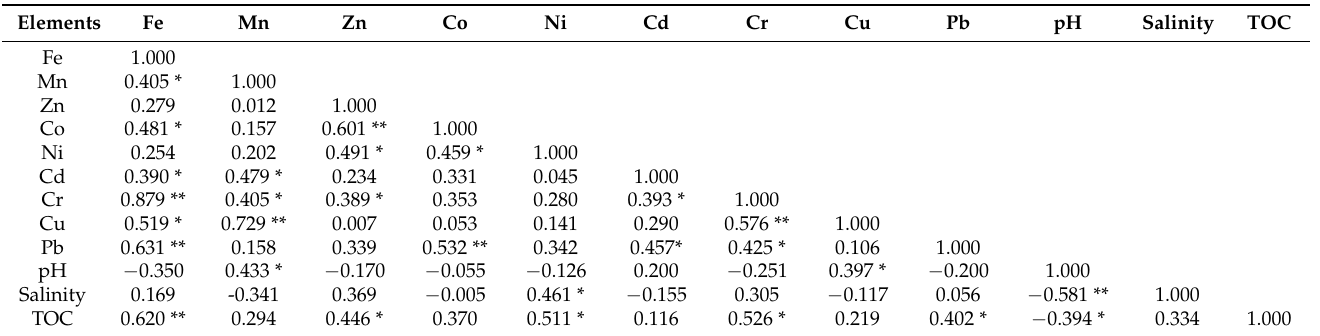
Table 5. Pearson correlation matrix for heavy metals concentration in surface sediments from the Qinjiang